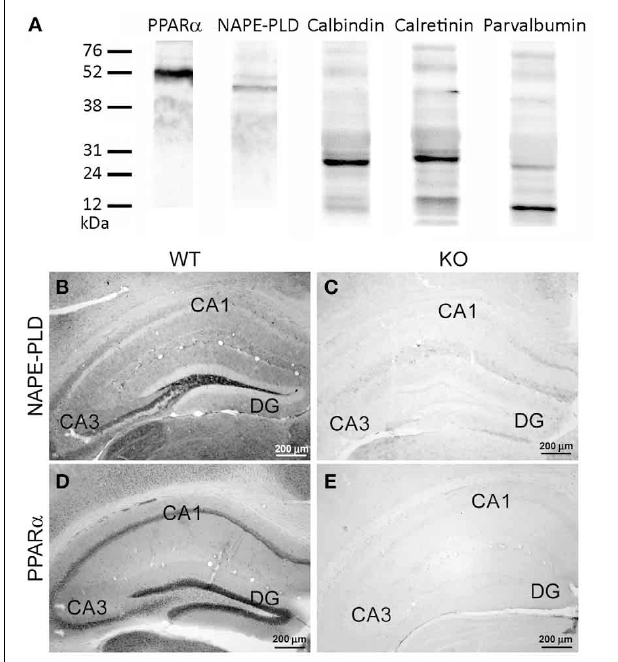
FIGURE 1 | (A) Western blot analysis of protein extracts from the rat hippocampus showing the prominent immunoreactive bands of the